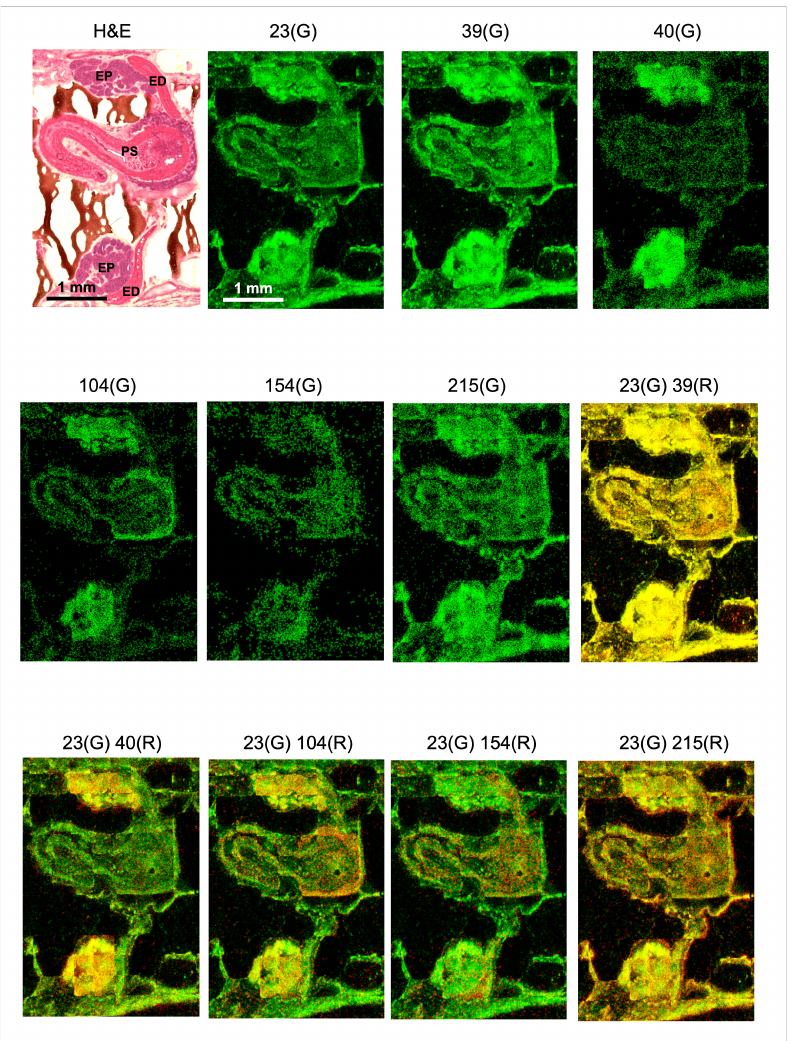
Figure 3. Low molecular mass organic compounds imaged in the epididymis by STCM IMS. The morphology of the male reproductive system is shown at the left top with H&E staining (ED: ejaculatory duct; EP: epididymis; PS: penis sheath; calibration: 1 mm). Localization of ionized sodium (Na, m / z 23), ionized potassium (K, m / z 39), and ionized calcium (Ca, m / z 40) are shown in green. In addition, m / z 104, m / z 154, and m / z 215 are imaged in green (see text for the assignment of these ions). The overlay of sodium ions in green (G) and five other ionized molecules in red (R) accentuated differences in the ion distribution pattern and helped us to identify the localization pattern unique to individual molecules. Calibration (1 mm) in 23G is shared by the rest of the MS